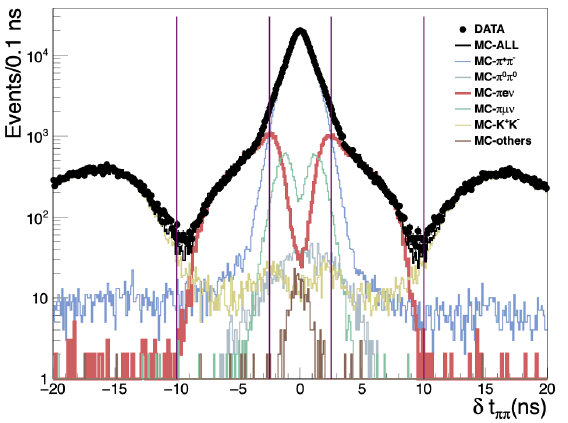
Figure 4 . Distributions of δt ππ for data and simulated signal and background events. The vertical lines indicate the selected range 2.5 ns < | δt